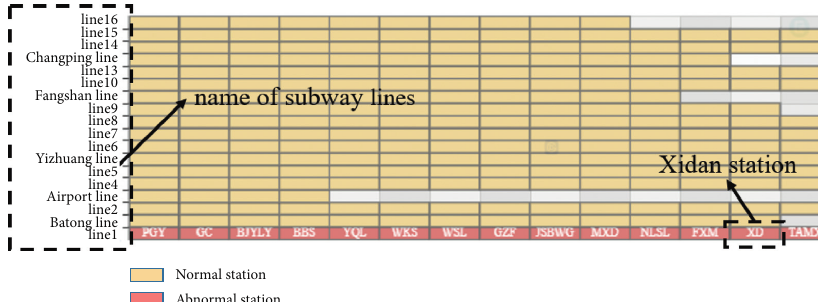
Figure 4: The overview of anomalies: this view shows the overview of abnormal stations on the whole metro system at a certain time. The longitudinal coordinates represent the line name, and each grid represents the corresponding station of the line. The normal stations are expressed by yellow, the abnormal stations are expressed by red, and the abbreviations of the station names are displayed.